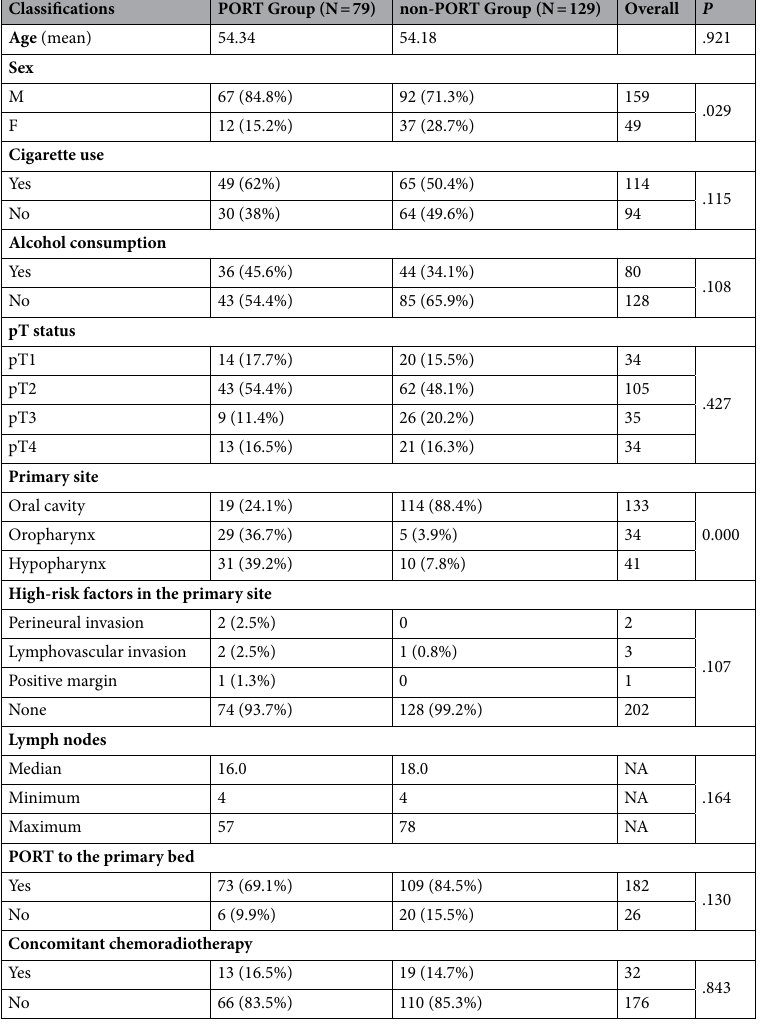
Table 1. Clinical characteristics. M male, F female, pT status pathologic tumor status, NA not